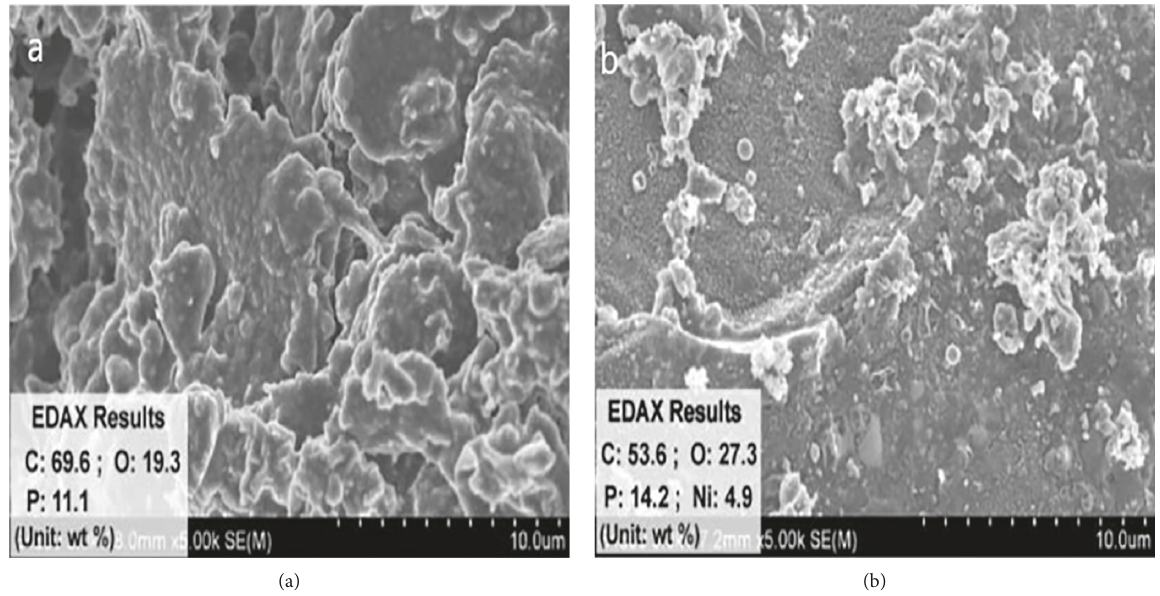
Figure 11: SEM images of char residue: (a) polypropylene-based 20% PN lignin composites and (b) polypropylene-based 20 PN-lignin-Ni composites (reprinted with permission from reference [229]; Copyright @ 2012 American Chemical